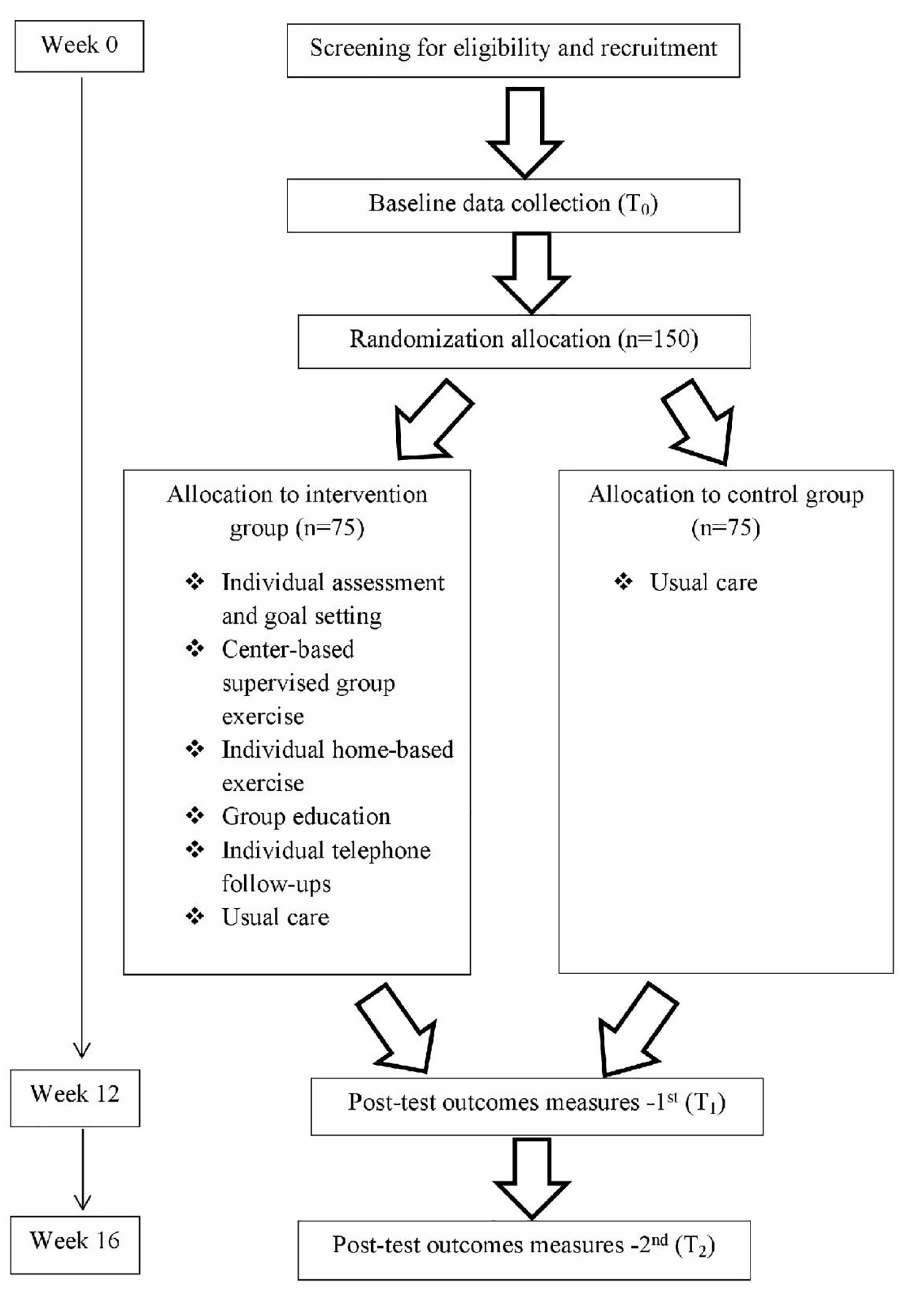
Fig 2. Flow diagram of the study